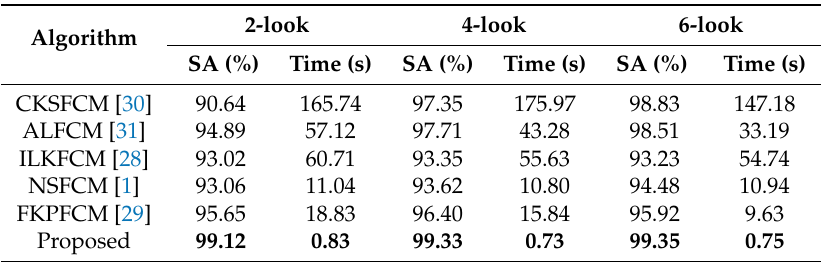
Table 1. Experimental results on SI1 simulated image.